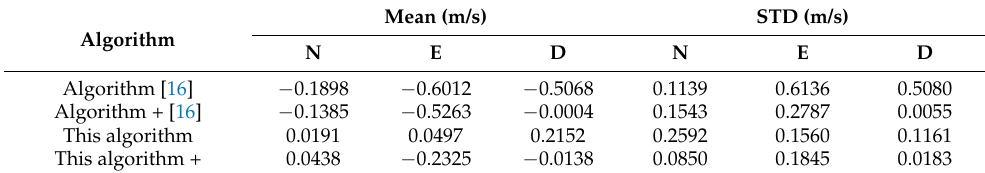
Table 4. Statistical comparison of velocity